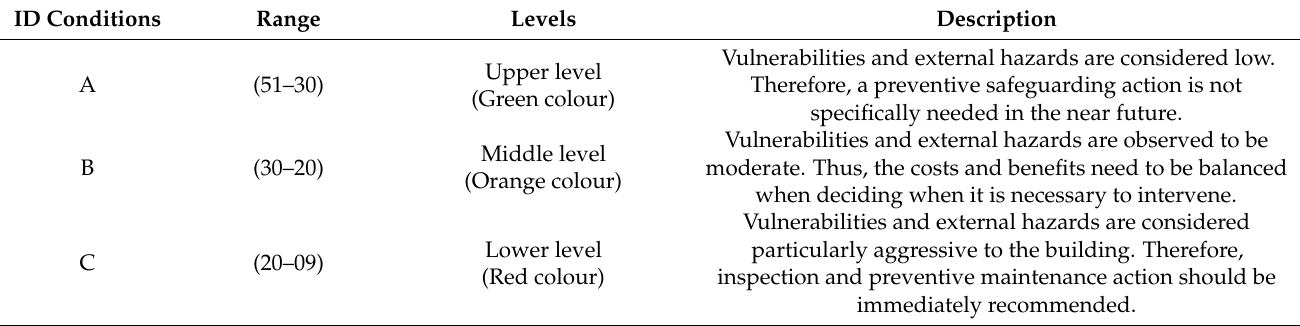
Table 6. Functional performance states in the context of southern Chile (Araucan í a